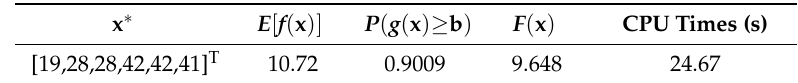
Figure 6. Variations of ST and